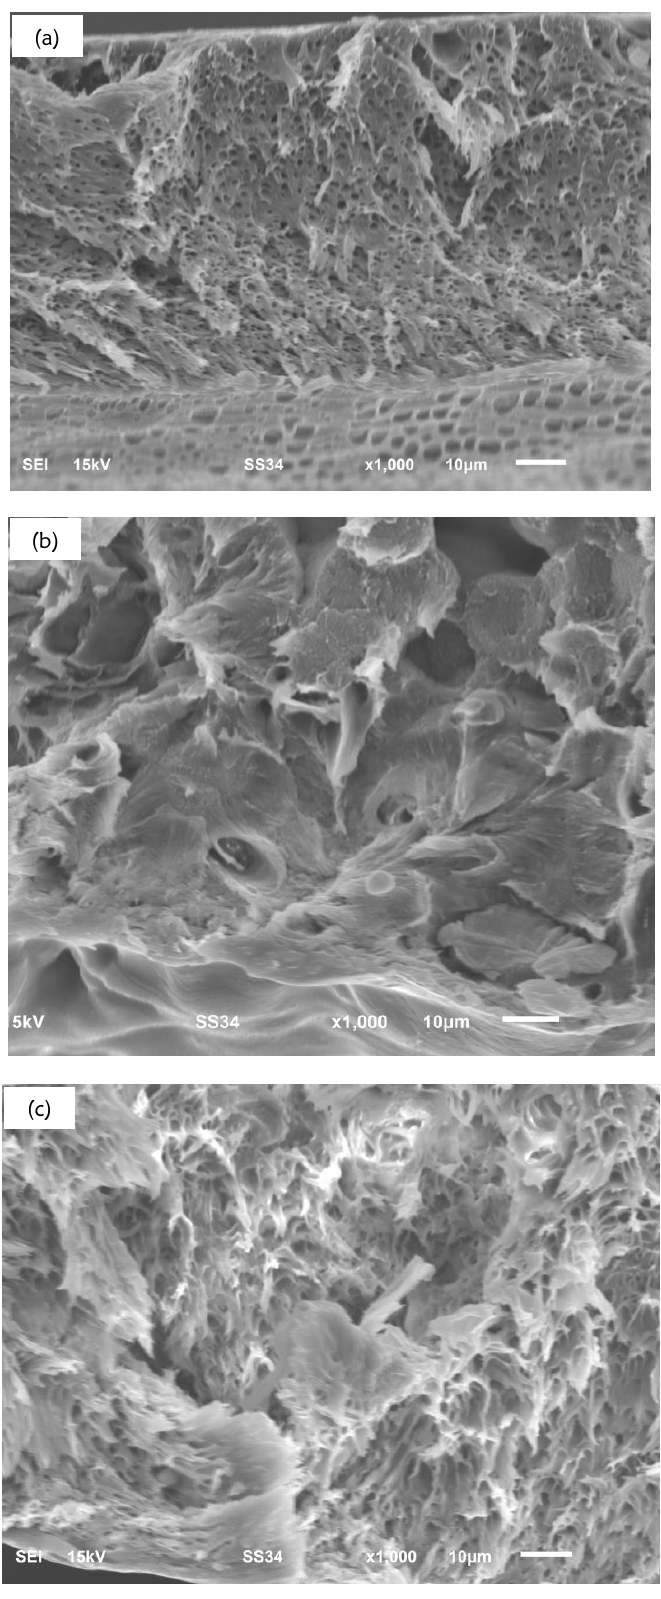
Figure 4: SEM micrographs of tensile fracture specimens at 1000x magnification (a) PLA, (b) PLA/DSF and (c)